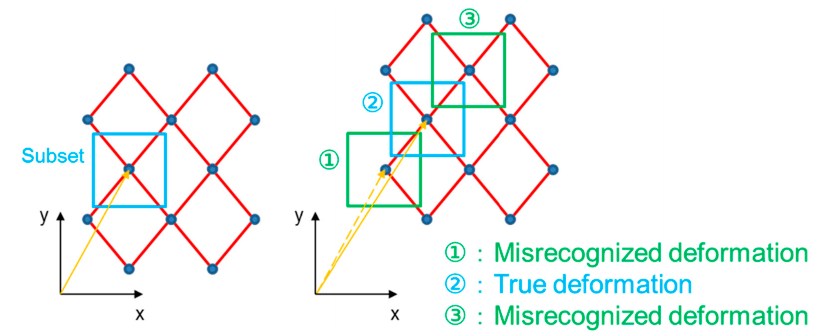
Figure 9. Comparison of horizontal displacement distributions obtained by DIC and SiDIC for the control paths highlighted in Figure 8: ( a ) Central dotted line; ( b ) Upper dotted line.